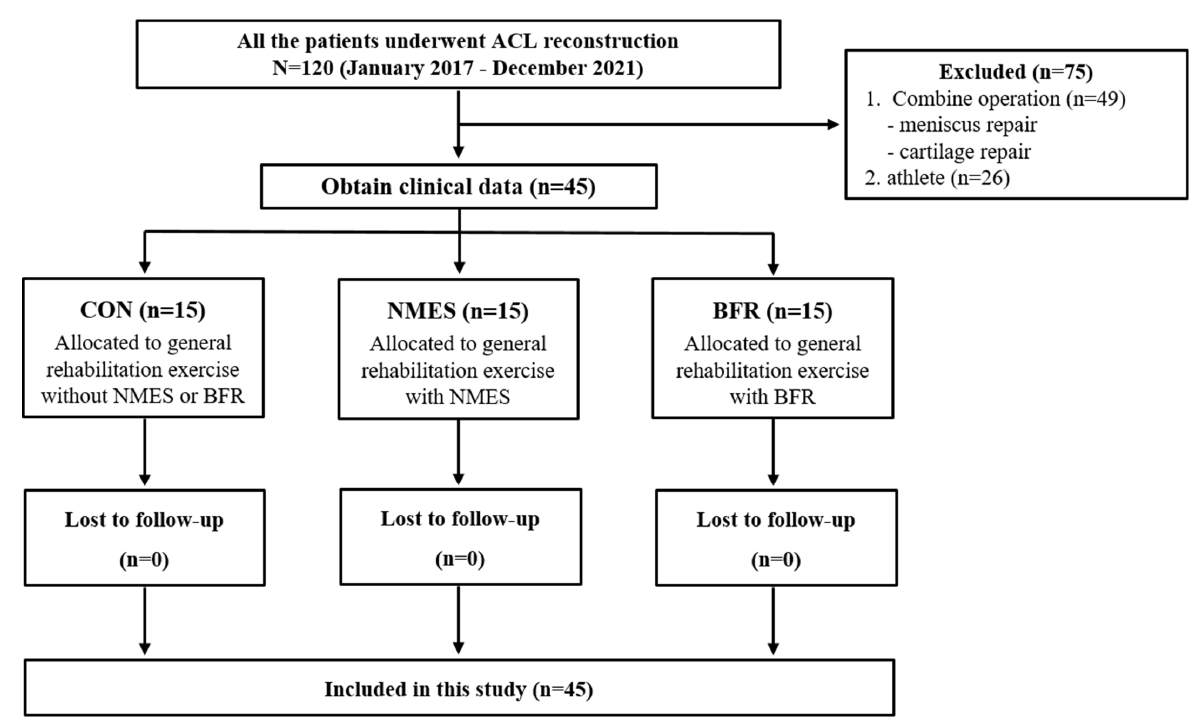
Figure 1. CONSORT flow chart. ACL, anterior cruciate ligament; CON, control; NMES, neuromuscu- lar electrical stimulation group; BFR, blood flow restriction group.